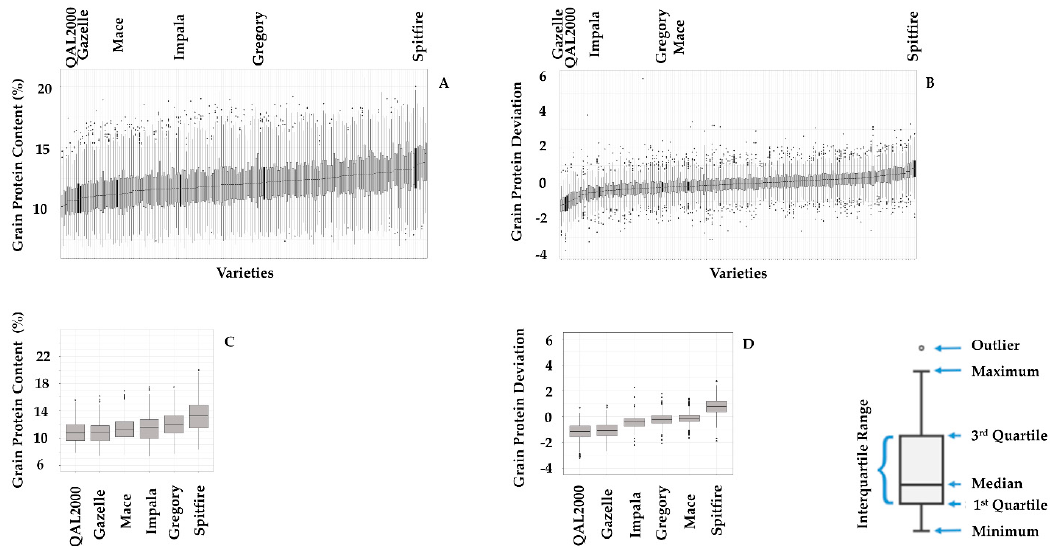
Figure 4. Grain protein content ( A , C ) and grain protein deviation ( B , D ) of 179 varieties in 206 sites, and 6 varieties in 168 sites from 2008 to 2018. ETs common between 6 varieties in ( C , D ) are ET1 / 2, ET2, ET2 / 3, and ET3 / 4. Grain protein deviation of each variety is calculated separately for each site, season, and year. The number of available trial data for each variety in ( A , C ) ranged from 50 to 896. The data available for the six selected varieties in ( C , D ) were: Spitfire: 366, Mace: 823, Gregory: 680, Impala: 429, QAL2000: 305 and Gazelle: 371. Boxes refer to the 25th (first quartile), 50th (median), and 75th (third quartile) percentile of data. ( A , B ) are obtained and modified from the Supplementary Figure S2 of Rahimi Eichi et al., 2019.